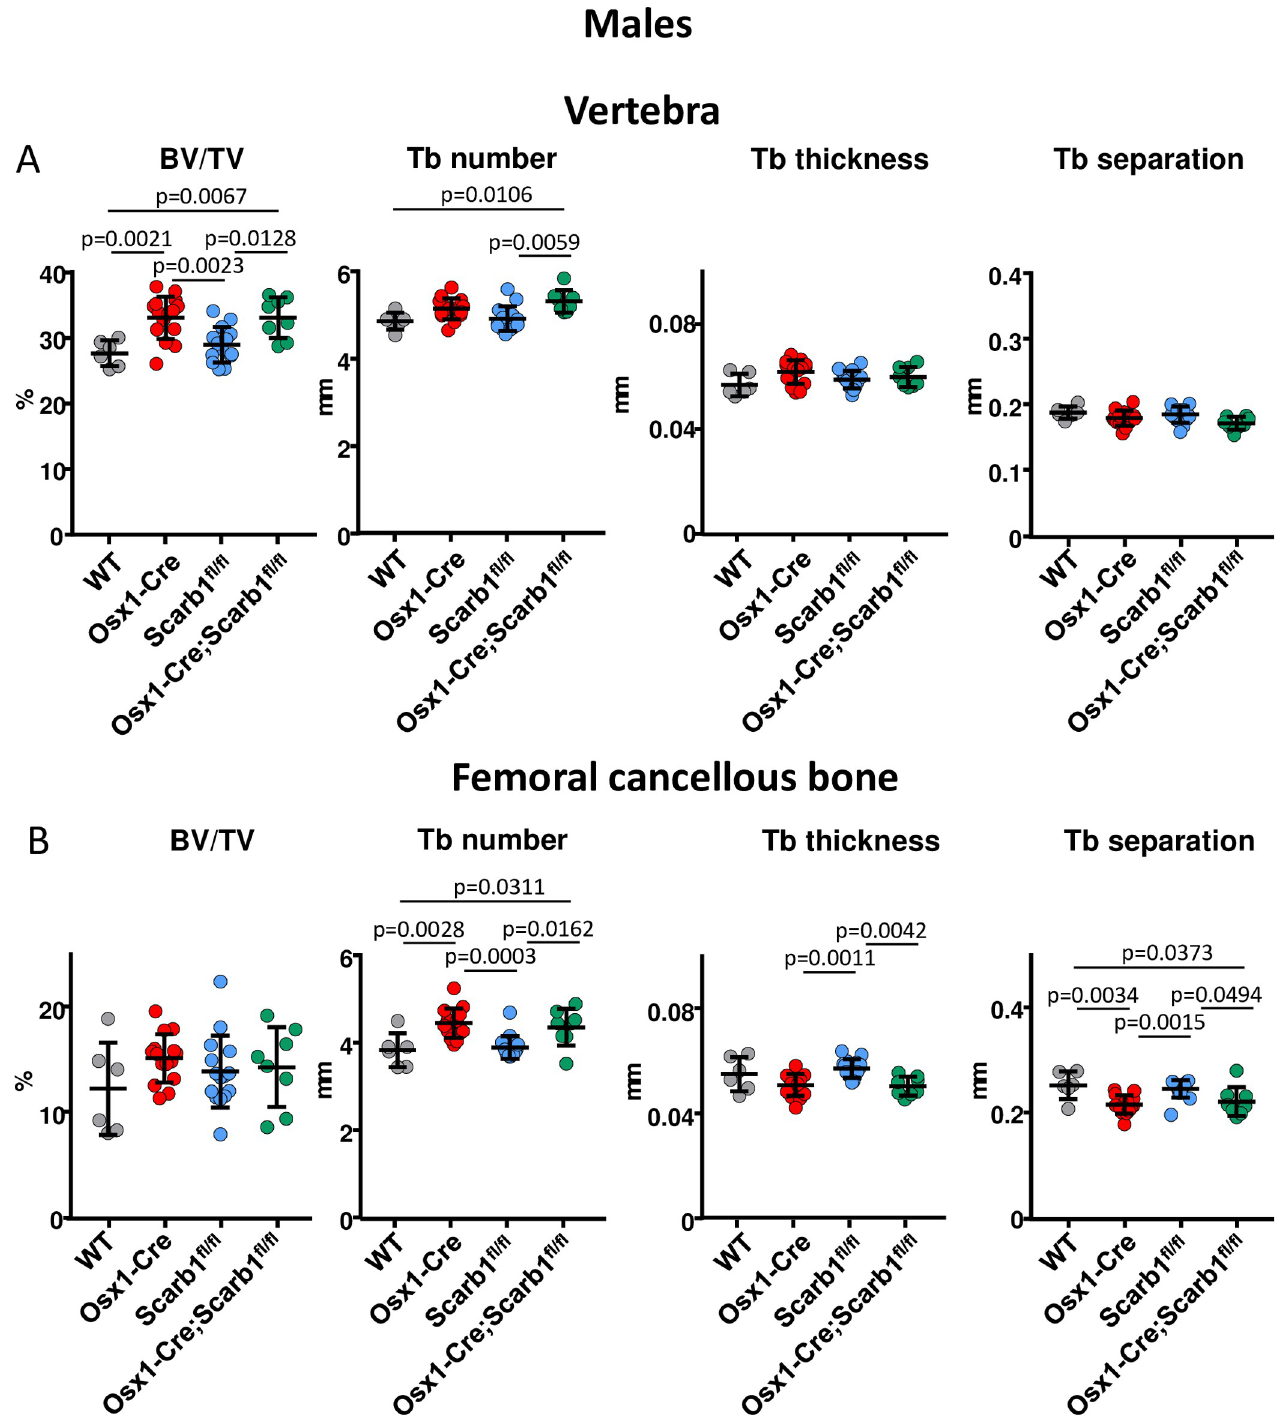
Fig 6. Deletion of Scarb1 in Osx1-Cre expressing cells does not affect trabecular bone in male mice. Micro-CT determination of trabecular bone architecture in 7-month-old male mice in (A) vertebra [WT n = 6; Osx1-Cre n = 15; Scarb1 fl/fl n = 14; Osx1-Cre;Scarb1 fl/fl n = 8] and (B) femoral metaphysis [WT n = 6; Osx1-Cre n = 15; Scarb1 fl/fl n = 15; Osx1-Cre;Scarb1 fl/fl n = 8]. Data are shown as mean and standard deviation. Data analyzed by ANOVA, the p- values were adjusted using the Tukey’s pairwise comparison procedure. BV/TV, bone volume /total volume. Tb, trabecular.